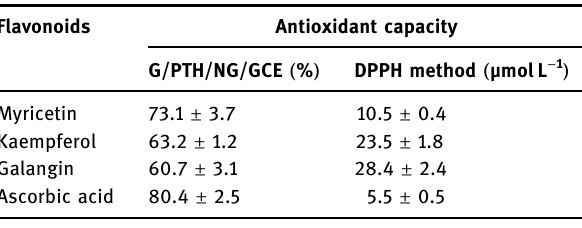
Table 2: Determination of antioxidant capacities of myricetin, kaempferol, and galangin compared to ascorbic acid using G/PTH/ NG/GCE and DPPH method Flavonoids